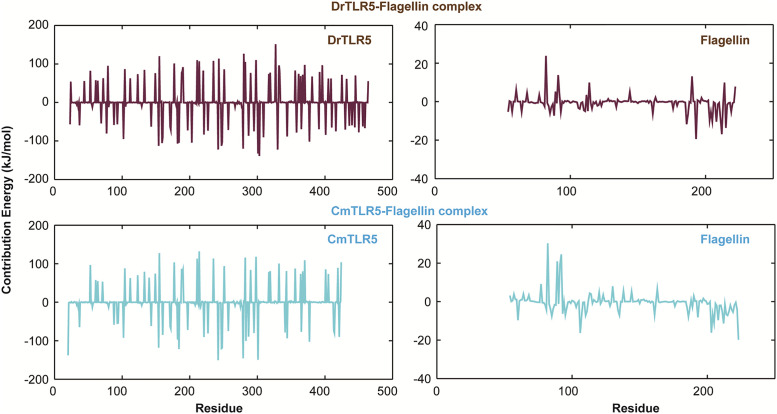
Per residue decomposition analysis displaying the contribution of each residue towards binding free energy in DrTLR5-Flagellin and CmTLR5-Flagellin complex systems.